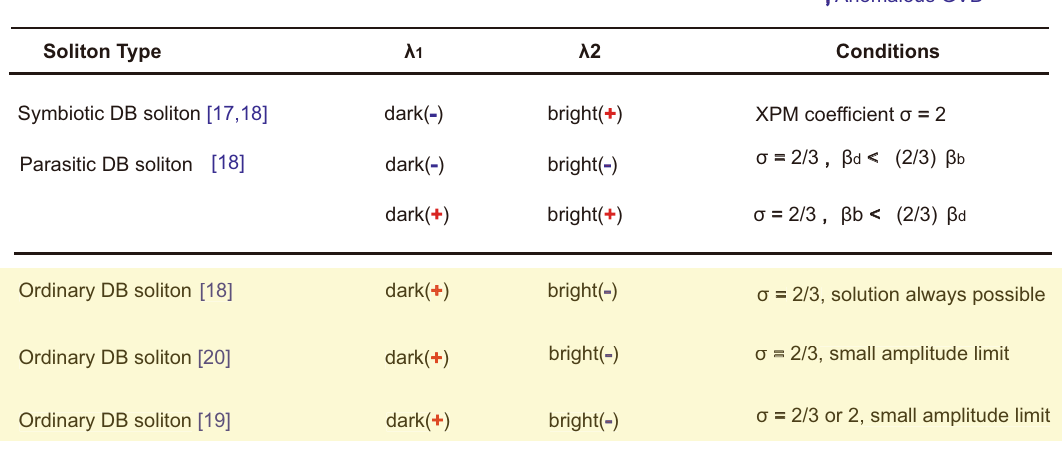
Table 2 Theoretical predictions on vector dark-bright solitons and their formation